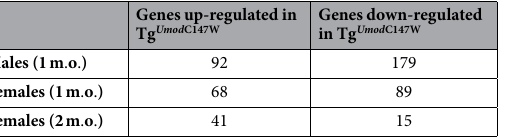
Genes up-regulated in Tg Umod C147W Males (1 m . o . ) 15 Table 1. Genes differentially expressed in kidneys of Tg Umod C147W mice relative to age- and sex-matched Tg Umod wt mice. Only genes showing fold change > 2 and Benjamini Hochberg adjusted P < 0.05 were considered as differentially